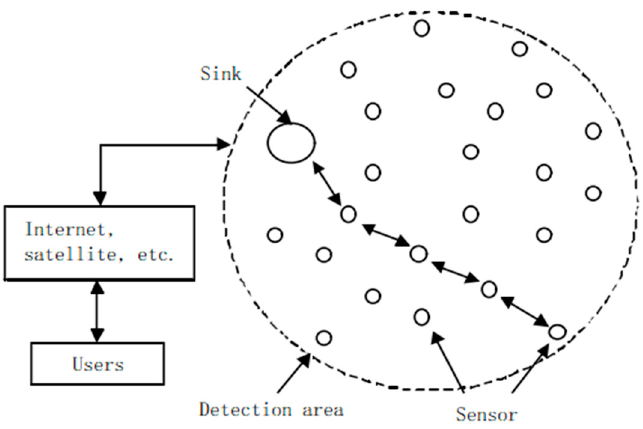
Figure 1. Wireless sensor network structure.